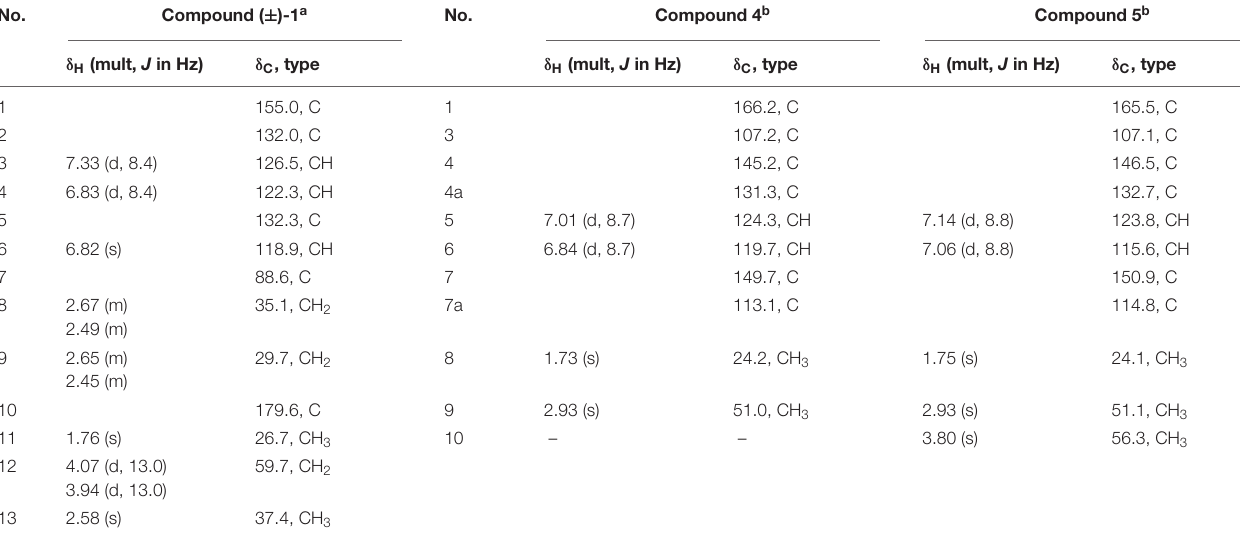
TABLE 1 | 1 H (500 MHz) and 13 C NMR (125 MHz) data of the new compounds 1, 4, and